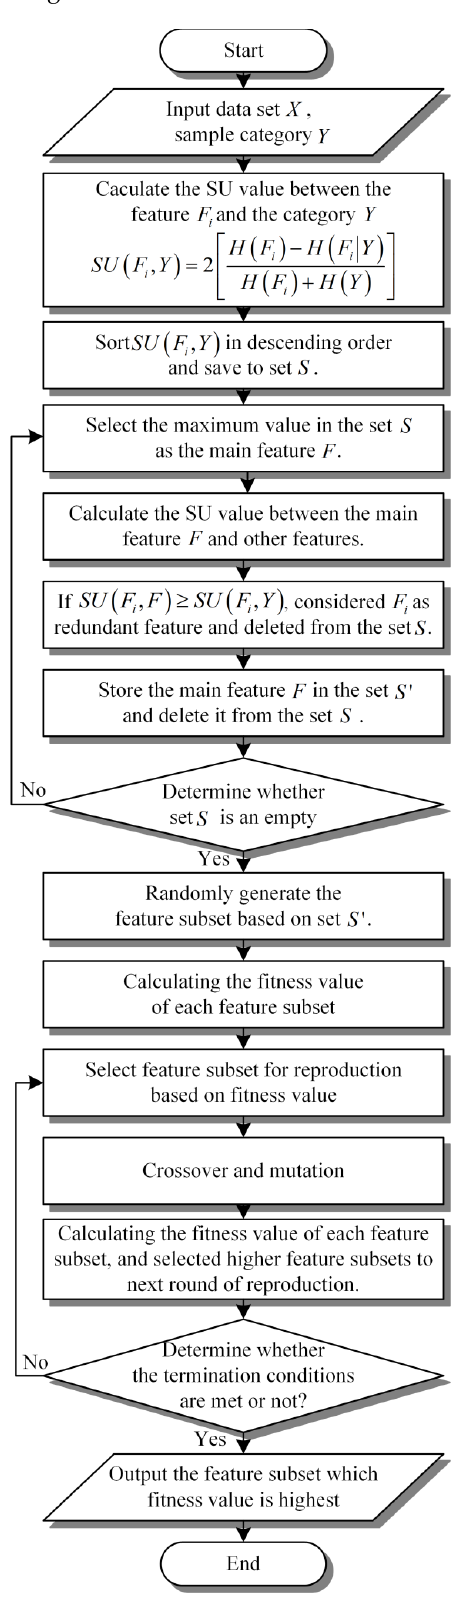
Figure 7. The flow chart of SU-GA.